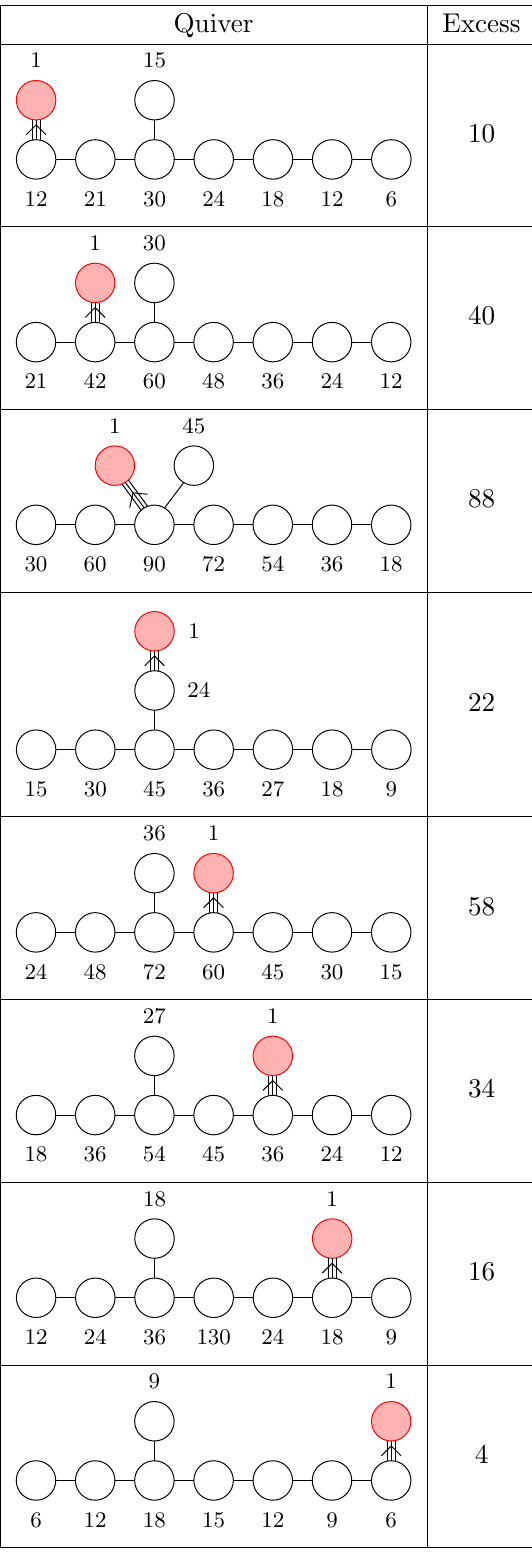
Table 27 . Exotic minimally unbalanced quivers of E 8 -type with inward triple laced